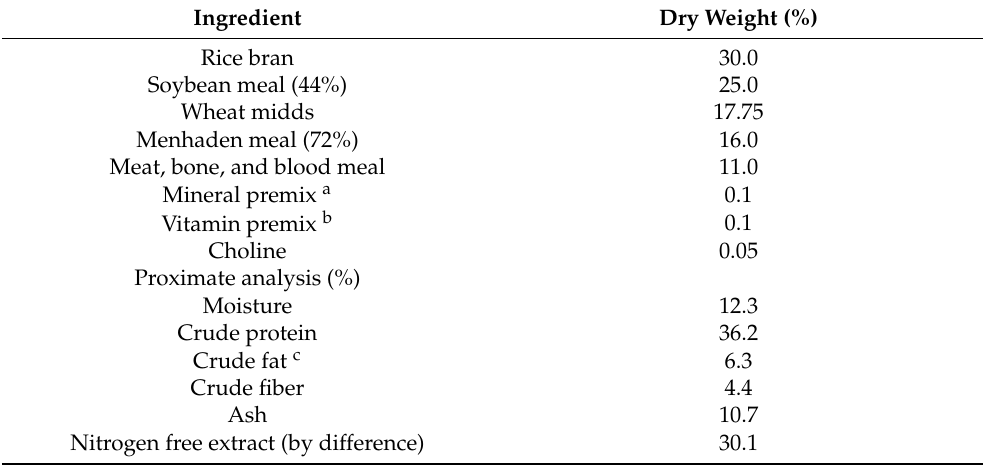
Table 1. Ingredient composition and proximate analysis of commercial feed used for M. rosenbergii